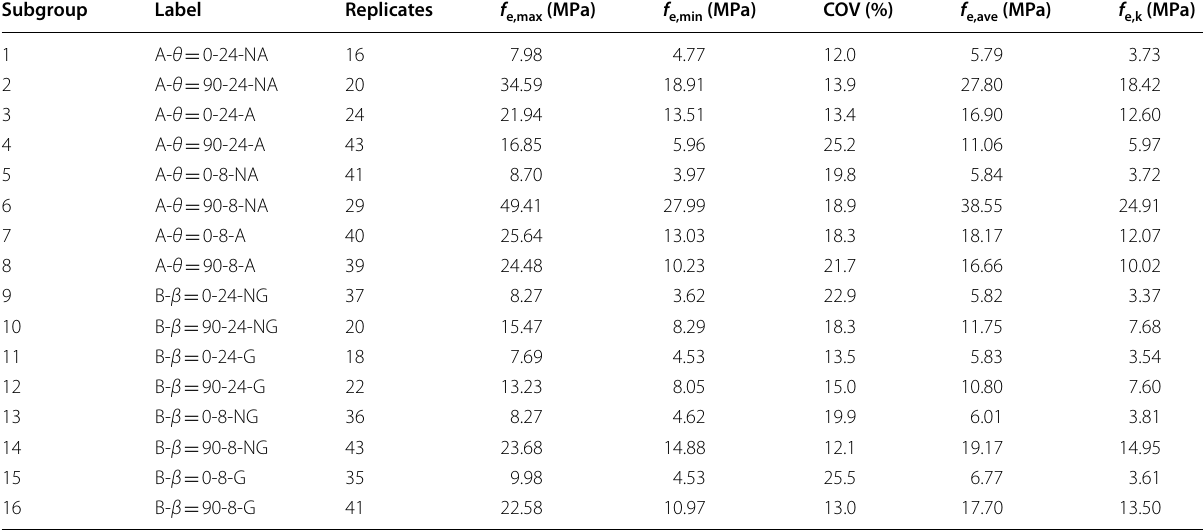
f e,k was calculated based on the method from EN 14358 [26]